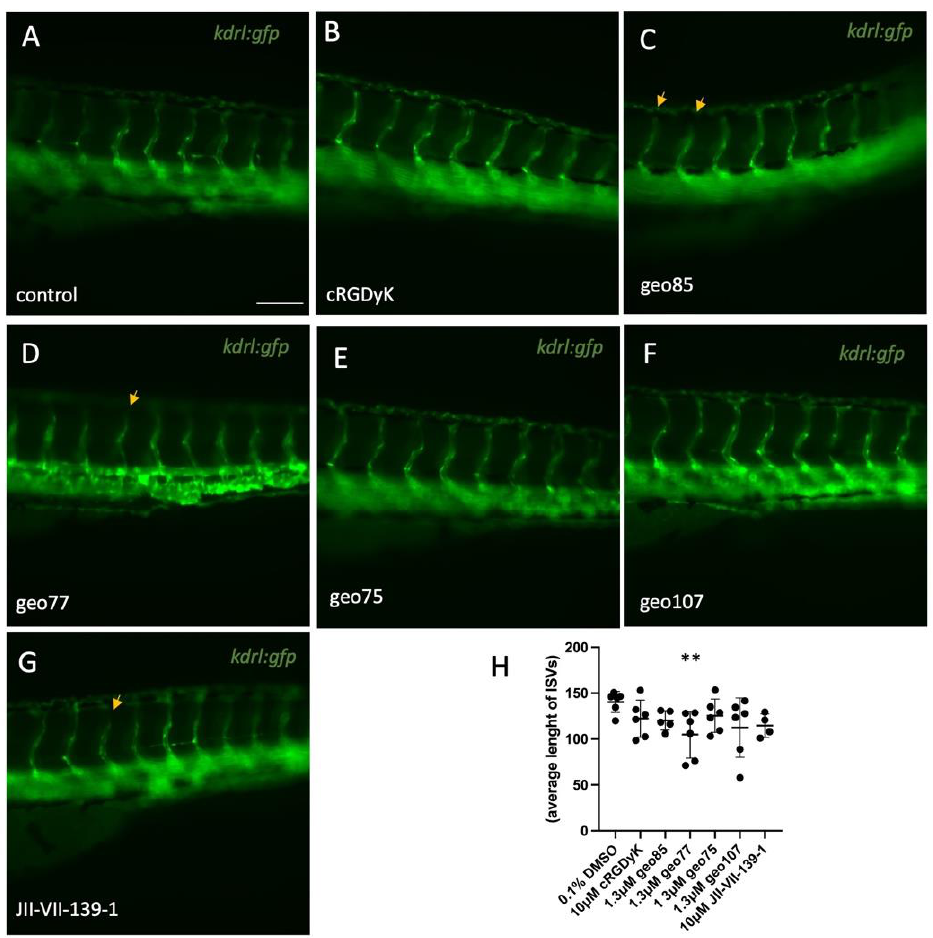
Figure 10. geo77 also affects the length of ISVs. ( A – G ) Fluorescence microscopy images of representative Tg(kdrl:gfp) embryos treated from 24 hpf, and DMSO-treated control at 72 hpf. Yellow arrows indicate sections of ISVs with decreased length angiogenesis. Scale bar, 100 µ m. ( H ) Estimated and presented total lengths of 8 ISVs per embryo. Compound geo77 (1.3 µ M) shows statistically significant inhibition on the total length of ISVs, while the other tested compounds show a non-significant trend at the tested concentrations. Data are expressed as mean ± SD ( n = 4–7/group). ** p < 0.05.